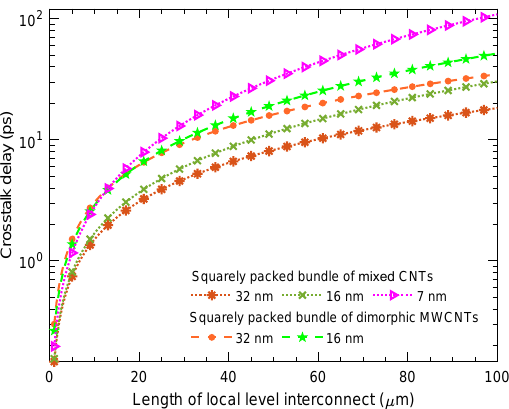
Figure 10. Comparative exhibition of the crosstalk delay of the proposed and previously developed bundle configurations for different technology nodes at local-level interconnect lengths. The dimen- sion of the used CNTs are the same as those used in the simulation for obtaining propagation delays at the local level.